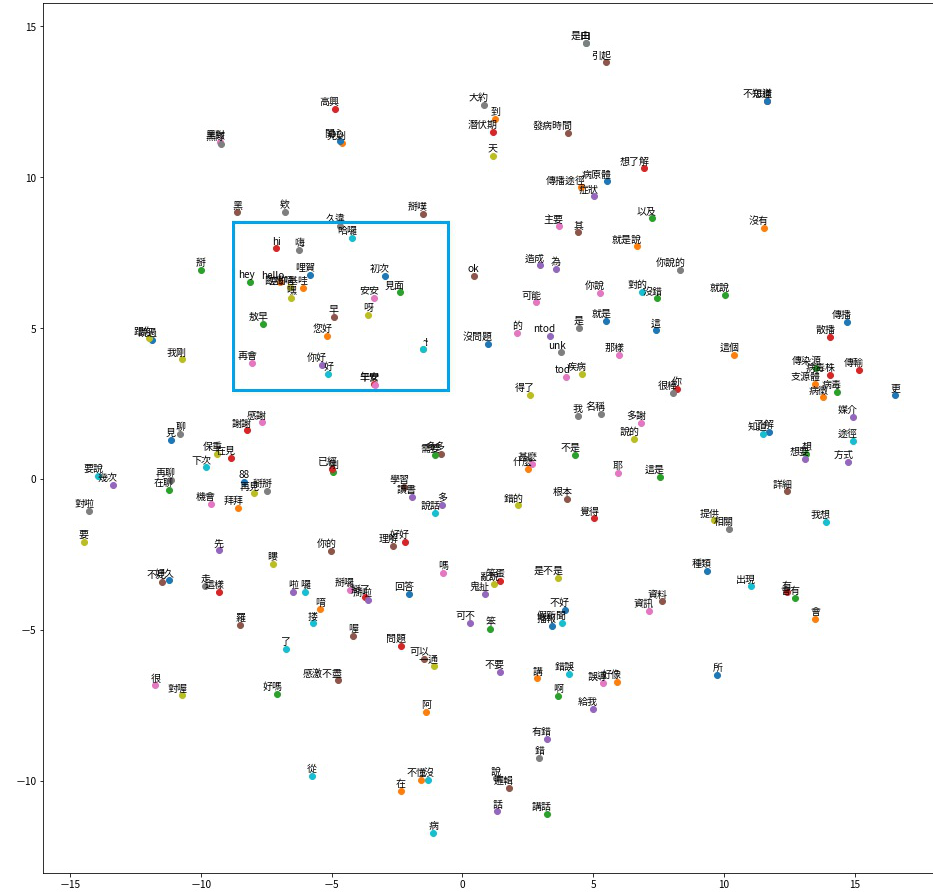
Figure 6. TSNE visualization of dialog acts vector.